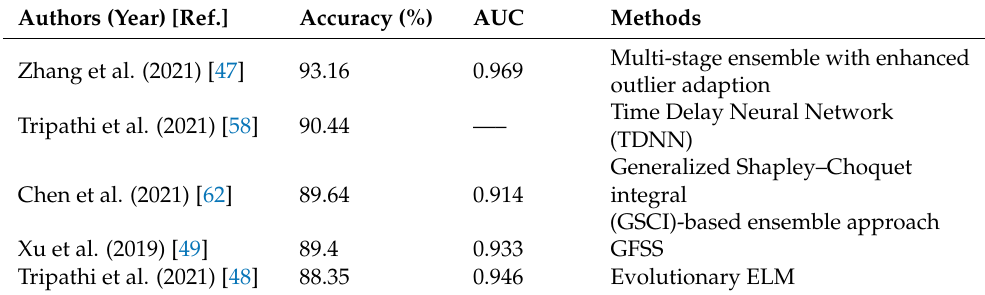
Table 5. Accuracy and area under the receiver operating characteristic curve (AUC) values of hybrid and ensemble classifiers for the Japanese dataset.